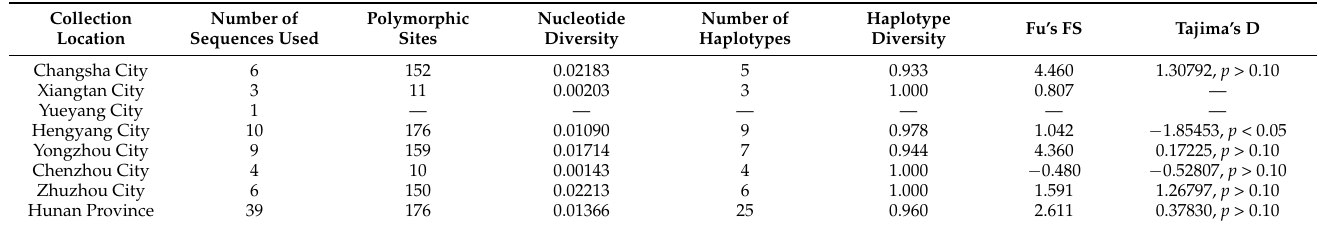
Table 3. Summaries of genetic diversity measurement and neutrality tests, based on the COI + COII + 12S + 16S + ND1 gene.